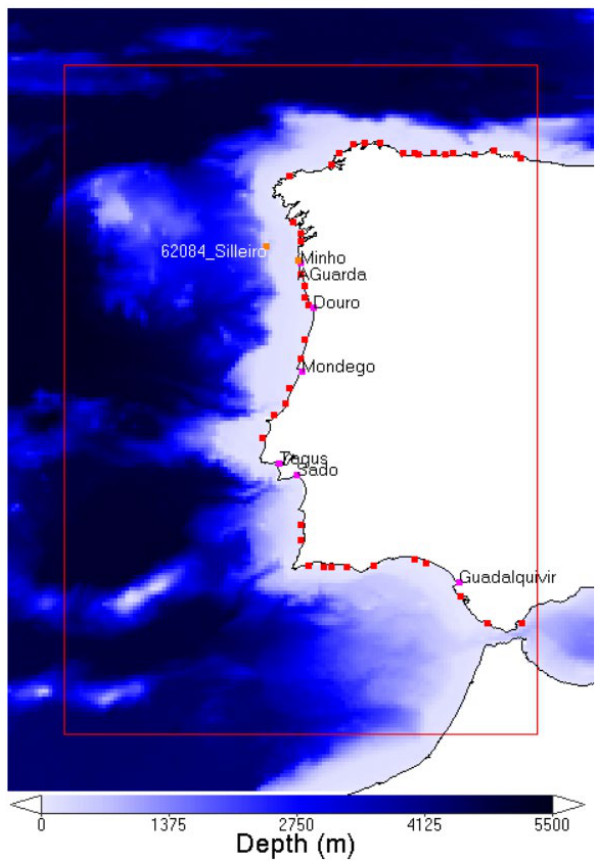
Figure 3. PCOMS regional ocean operational system domains and bathymetry. The full domain corresponds to the WestIberia 2D Domain where tide is imposed. The red box indicates the outer limit of the Portugal 3D Domain. Pink dots indicate the location of the six main estuaries in western Iberia. Red dots indicate the location of extra 45 rivers implemented with direct discharges. The locations of Silleiro and A Guarda monitoring stations are indicated by orange dots.